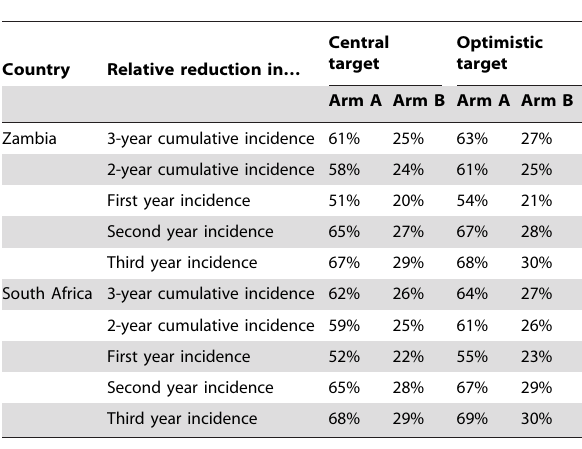
Table 2. Projected impact of the intervention on HIV incidence in Arms A and B compared with Arm C for central and optimistic target scenarios (specific parameter values for each scenario defined in Table S10 in File